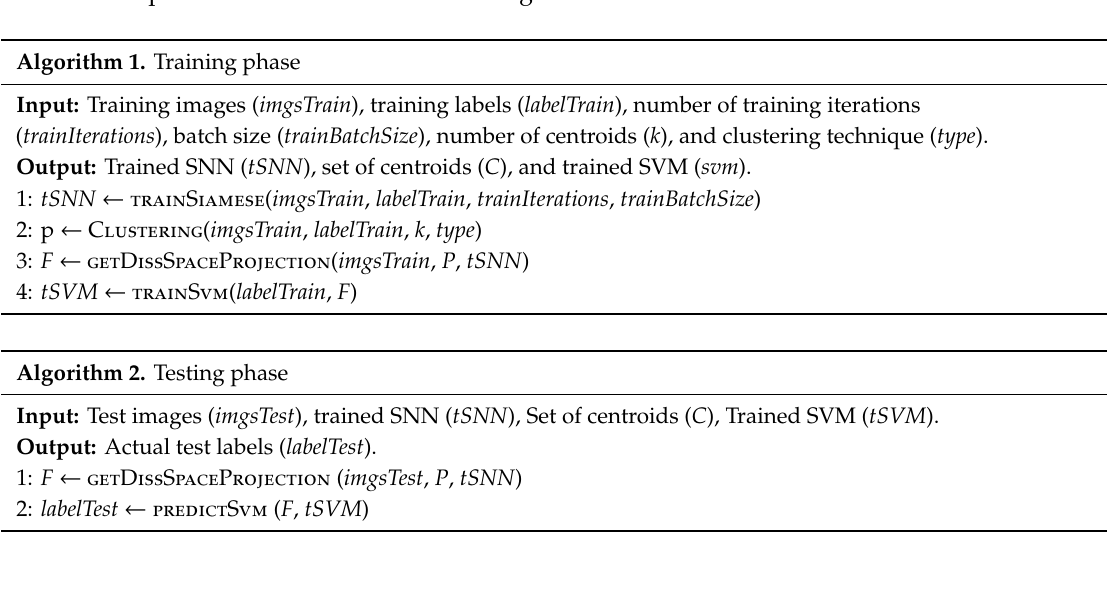
Algorithm 1 Training phase